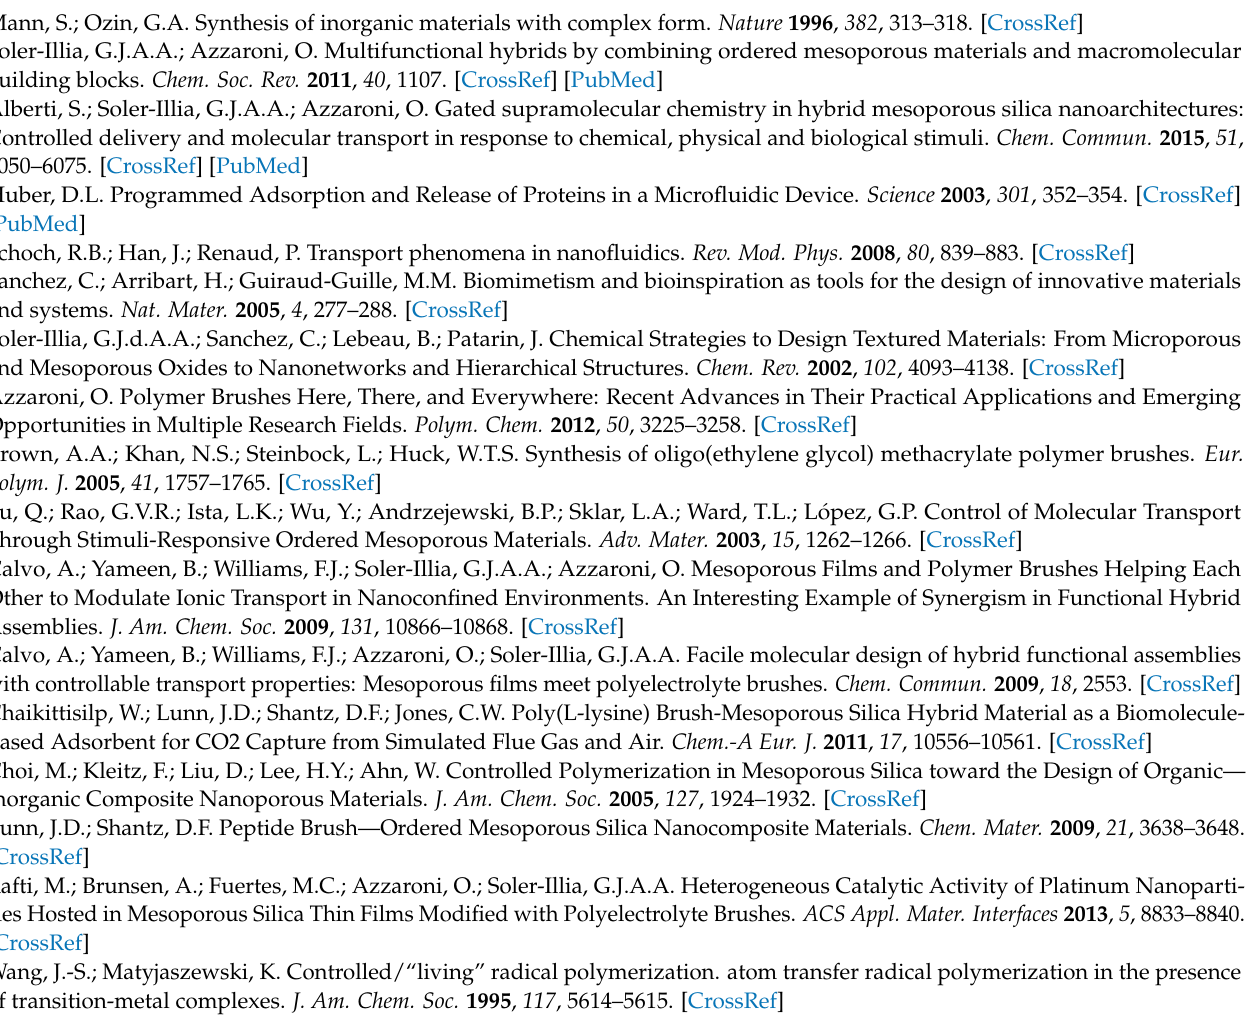
Table S1: Contact angle of different samples of mesoporous silica (controls) are compared to the full synthesis of the hybrid material. The “X” shows the steps of synthesis performed for each sample; Table S2: Contact angle of different samples of mesoporous titania (controls) are compared to the full synthesis of the hybrid material. The “X” shows the steps of synthesis performed for each sample. Author Contributions: S.A. performed the characterization and the synthesis of the samples and wrote the original draft; J.G. assisted with the polymerization and corrected the manuscript; O.A. and G.J.A.A.S.-I. supervised the project. All authors have read and agreed to the published version of the